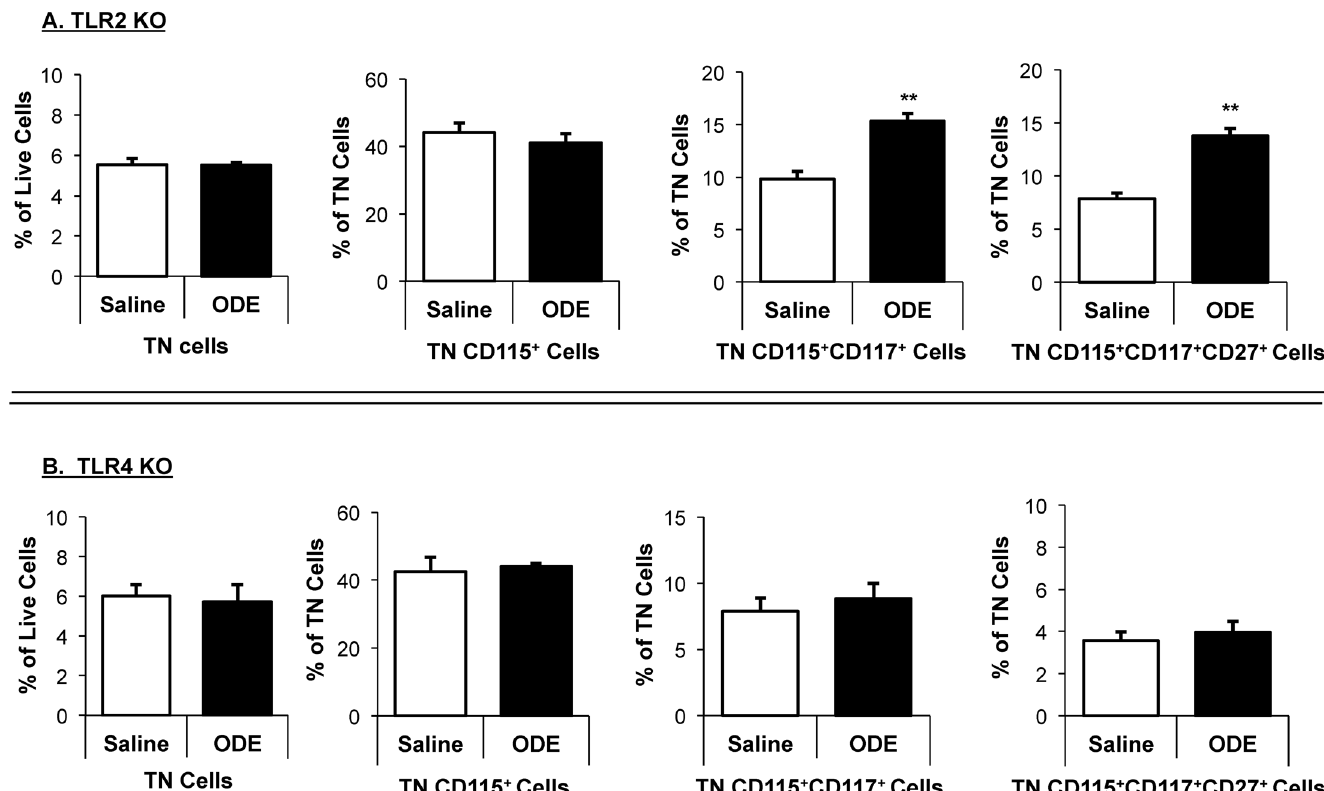
Fig 8. Increased osteoclast precursor populations (OCP) in murine bone marrow following inhalant ODE treatment is dependent upon TLR4, but not TLR2, signaling pathway. TLR2 KO ( A, top panel ) and TLR4 KO ( B, bottom panel ) mice were i . n . treated with saline or ODE daily for three weeks whereupon mice were euthanized and bone marrow cells were collected and analyzed by flow cytometry. After exclusion of debris and dead cells, triple negative (TN) cells were gated based upon CD45R - CD3 - CD11b lo phenotype. Distribution of TN cells are shown as mean percentage with SEM bars of live cells. Distribution of TN cells expressing CD115, CD115CD117, and CD115CD117CD27 are shown as mean percentage with SEM bars of TN cells. N = 4 mice/group. Statistical significance denoted by asterisks ( ** p < 0.01) vs. saline.